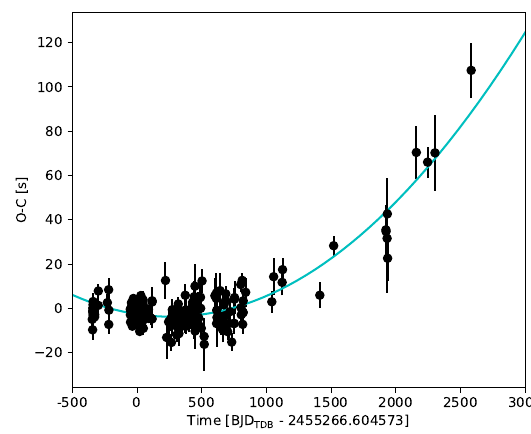
Figure 4. The O-C diagram of CS 1246 with both fortnightly and biennial sinusoidal variations pre-whitened. The resulting parabola indicates a period increase of (1.74 ± 0.08) × 10 −12 s s −1